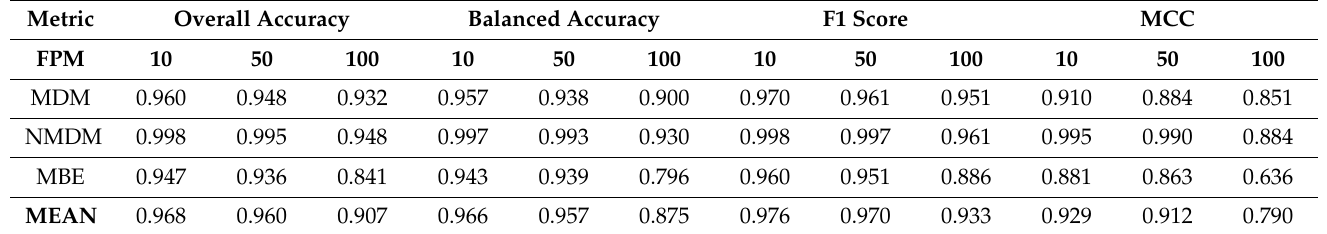
Table 5. Performance scores of sideview image features over different line speeds (10, 50, and 100 FPM): Average of 10 repeated five-fold